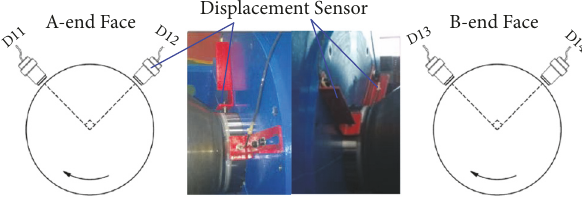
Figure 8: Schematic and installation of eddy current displacement